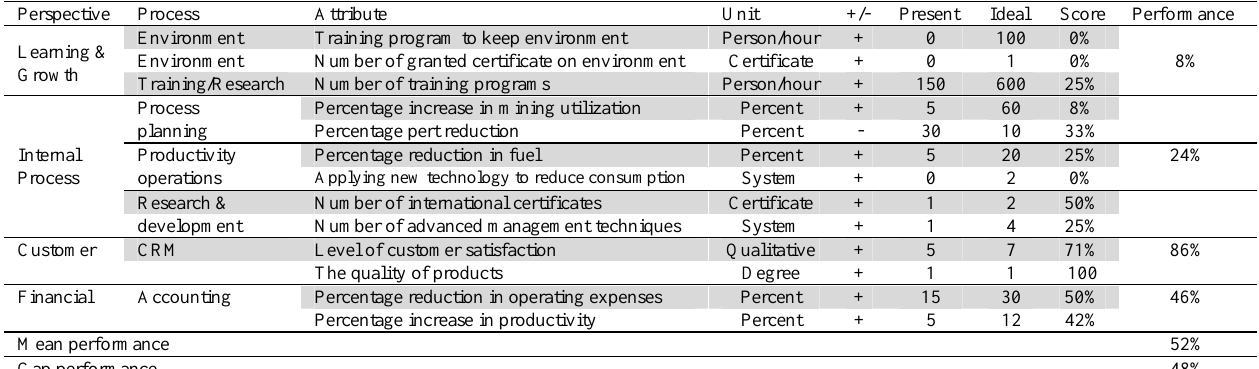
Performance measurement of organization based on BSC method